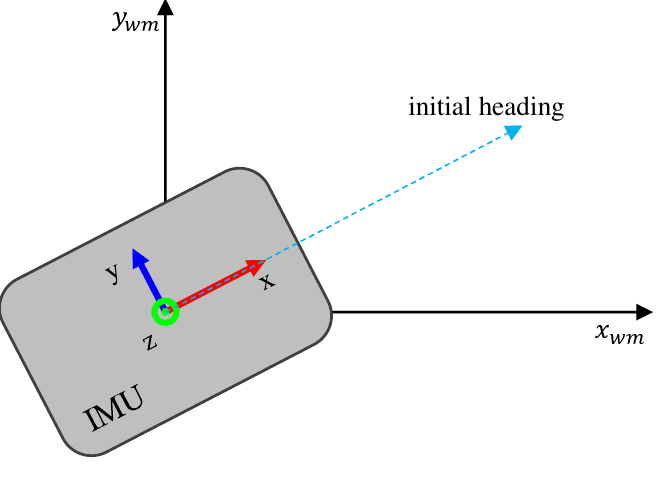
Figure 12. Calibrate IMU pose with initial